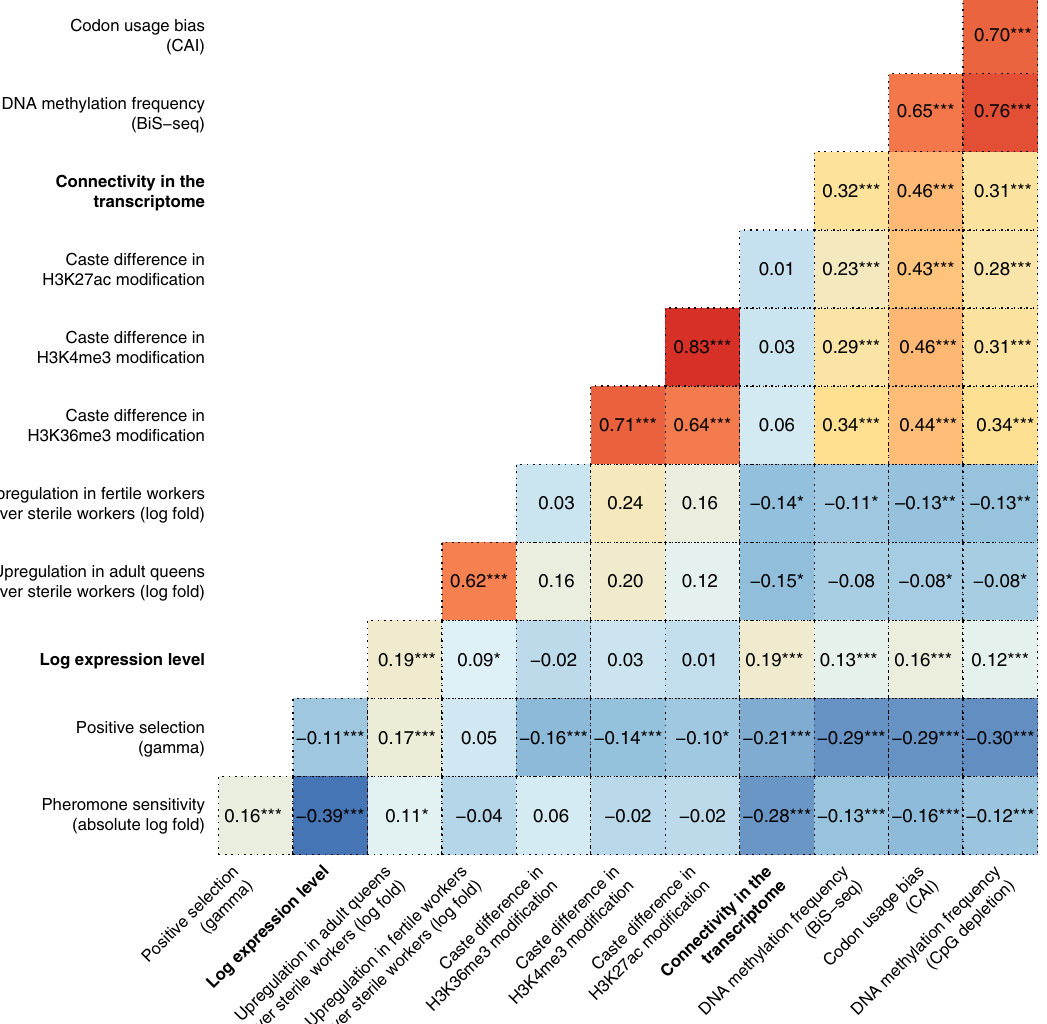
Fig. 5 Spearman correlations for various gene-level measurements from the present study and earlier research, for Apis mellifera . Measurements from the present study are shown in bold: ‘ Pheromone sensitivity ’ was calculated as the absolute value of the Log 2 fold difference in expression between pheromone treatment and the control. Expression level shows the logarithm of the average across our six Apis libraries. For the ‘ Upregulation in queens/fertile workers ’ data 15 , positive values denote genes that have higher expression in queens or fertile workers, relative to sterile workers. For the three histone modi fi cation variables 29 , high values indicate that the modi fi cation is more abundant in queen-destined larvae, and low values indicate it is more abundant in worker- destined larvae. The two DNA methylation variables give two different measures of the amount of gene body DNA methylation, namely an indirect measure ( − log CpG O/E ratio) and a direct measure (BiS-seq 80 ). Codon usage bias was estimated using the codon adaptation index: high values indicate bias for particular synonymous codons. Lastly, the parameter gamma ( γ ) describes the form of selection, where positive values denote positive selection, and negative values purifying selection 27 . The asterisks indicate Benjamini-Hochberg corrected p-values (* p < 0.05; ** p < 0.01; *** p <